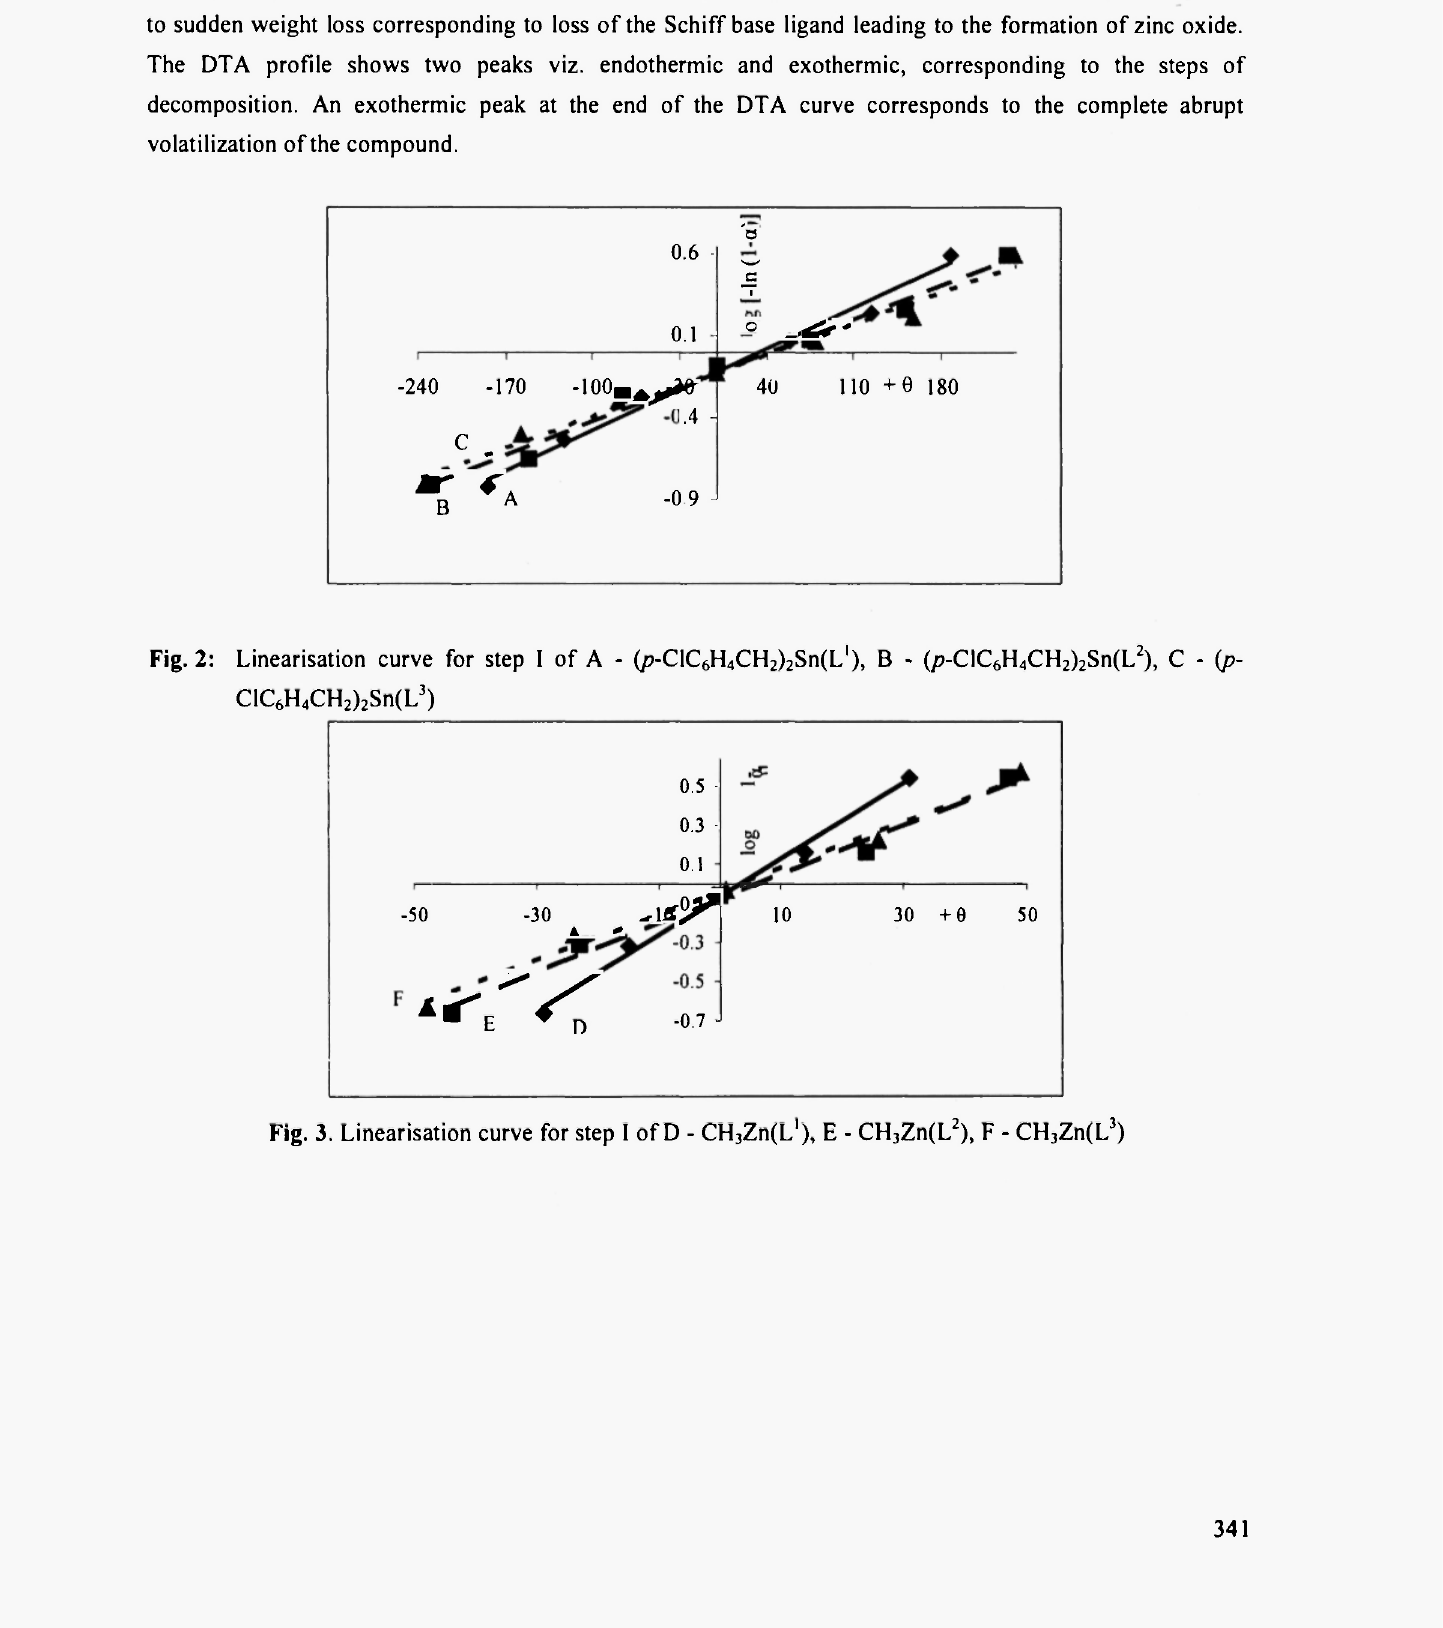
Fig. 2: Linearisation curve for step I of A - (p-ClC 6 H 4 CH 2 ) 2 Sn(L'),